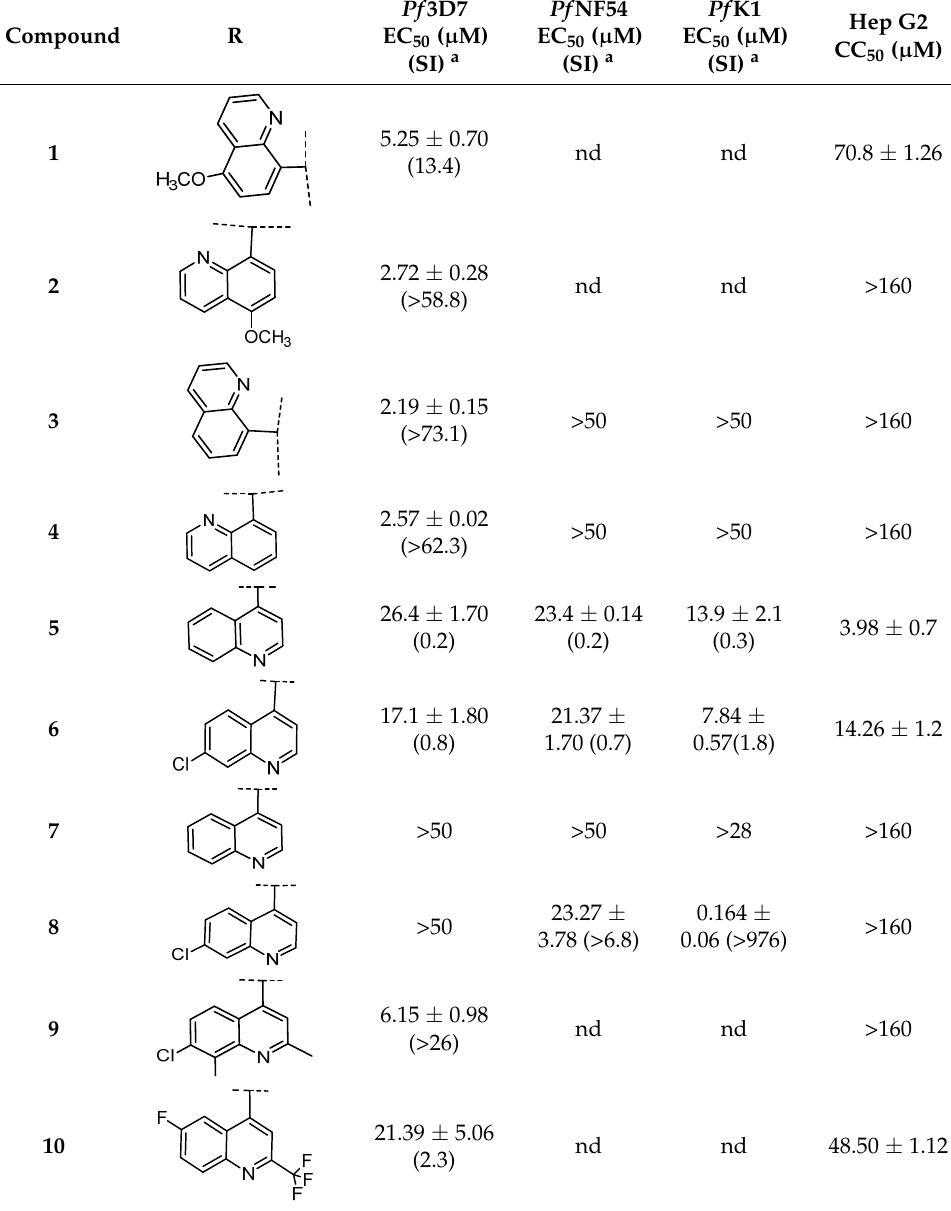
Table 1. Antiplasmodial activity of compounds 1 – 16.